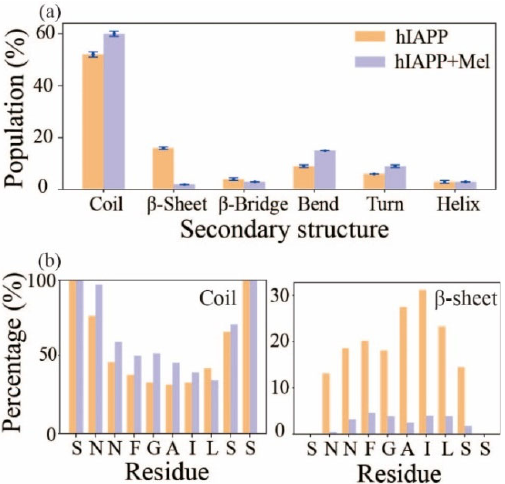
Figure 2. The secondary structure of the hIAPP 20–29 octamer in the absence and presence of Mel. ( a ) The populations of different secondary structures with error bars. ( b ) The percentages of coil and β -sheet of each amino acid residue.